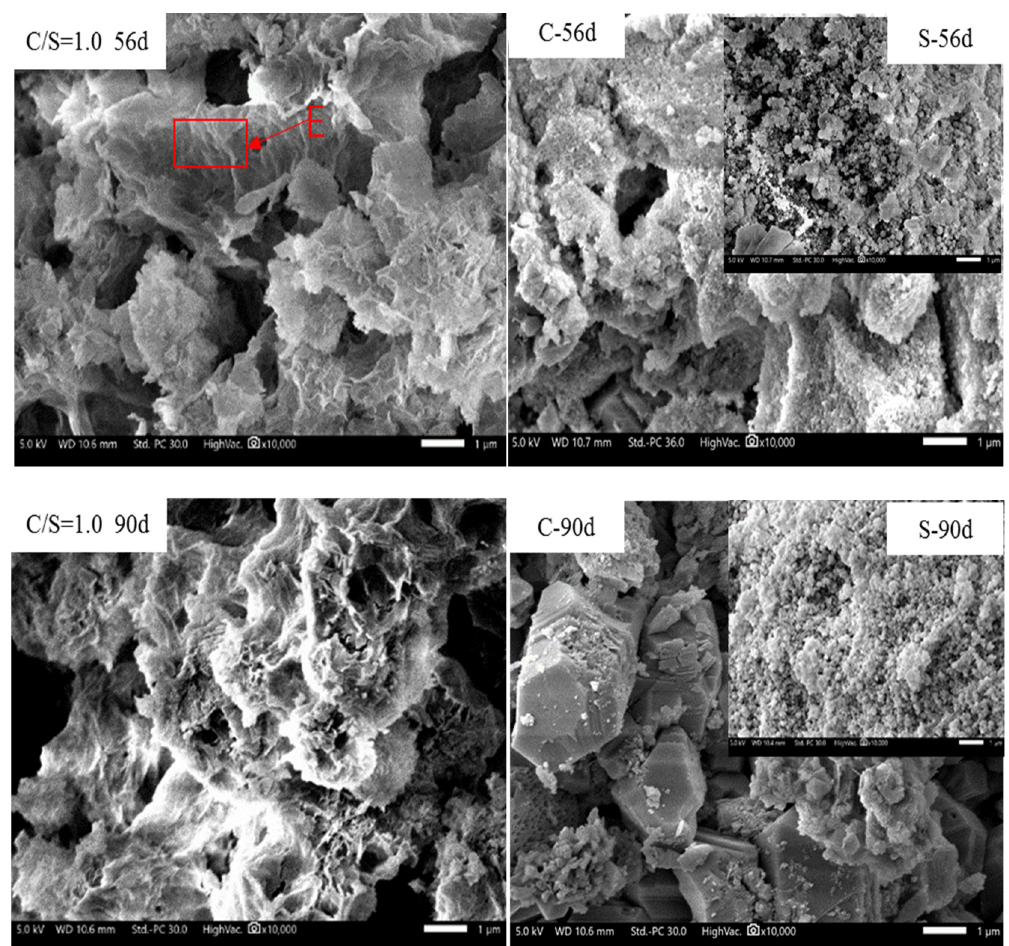
Figure 10. Microstructures of samples with an initial C/S molar ratio of 1.0.